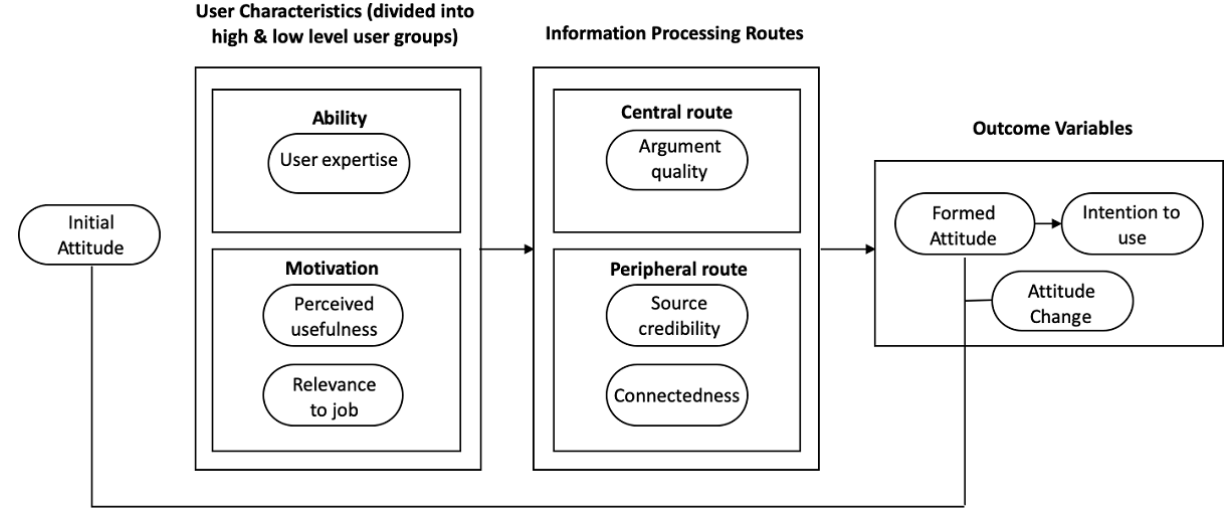
Figure 1. Research model to investigate attitudes and intention to use health care virtual community of